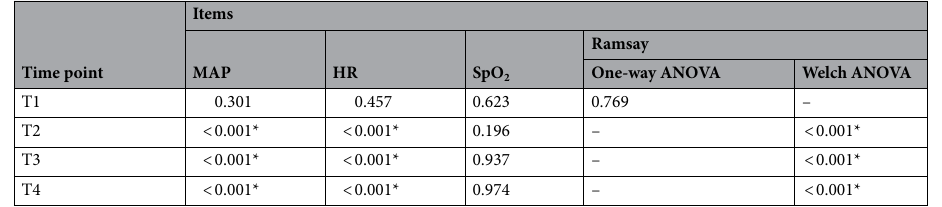
Table 1. P values of ANOVA for MAP, HR, SpO2, and Ramsay at four time points. MAP mean arterial pressure, HR heart rate, pulse SpO 2 oximeter oxygen saturation, T1 before anesthesia, T2 working cannula establishment, T3 nucleus pulposus removal, T4 immediately postoperation; *Difference was statistically significant.